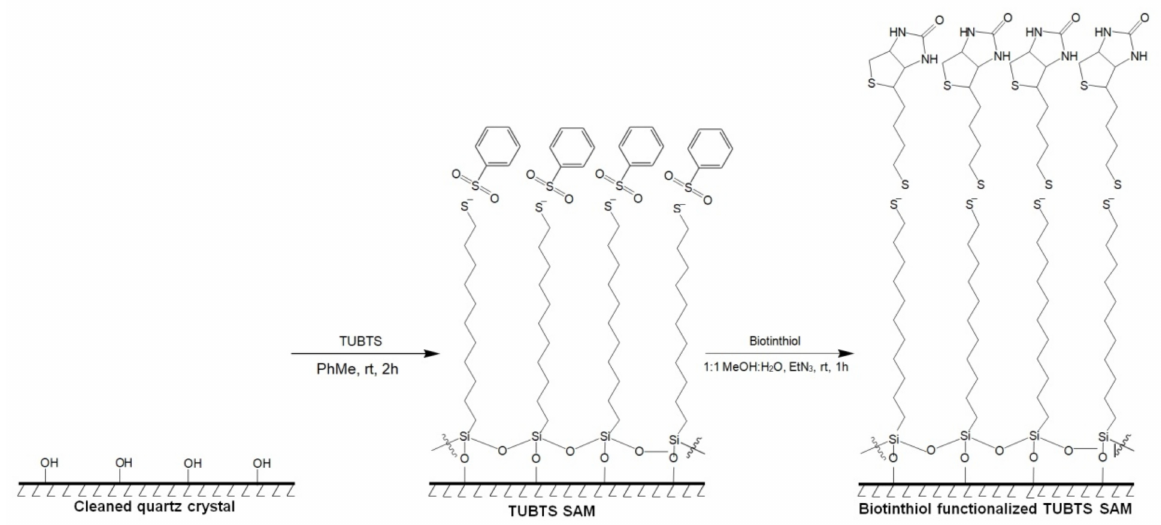
Figure 3. Surface attachment of TUBTS to quartz followed by immobilization of